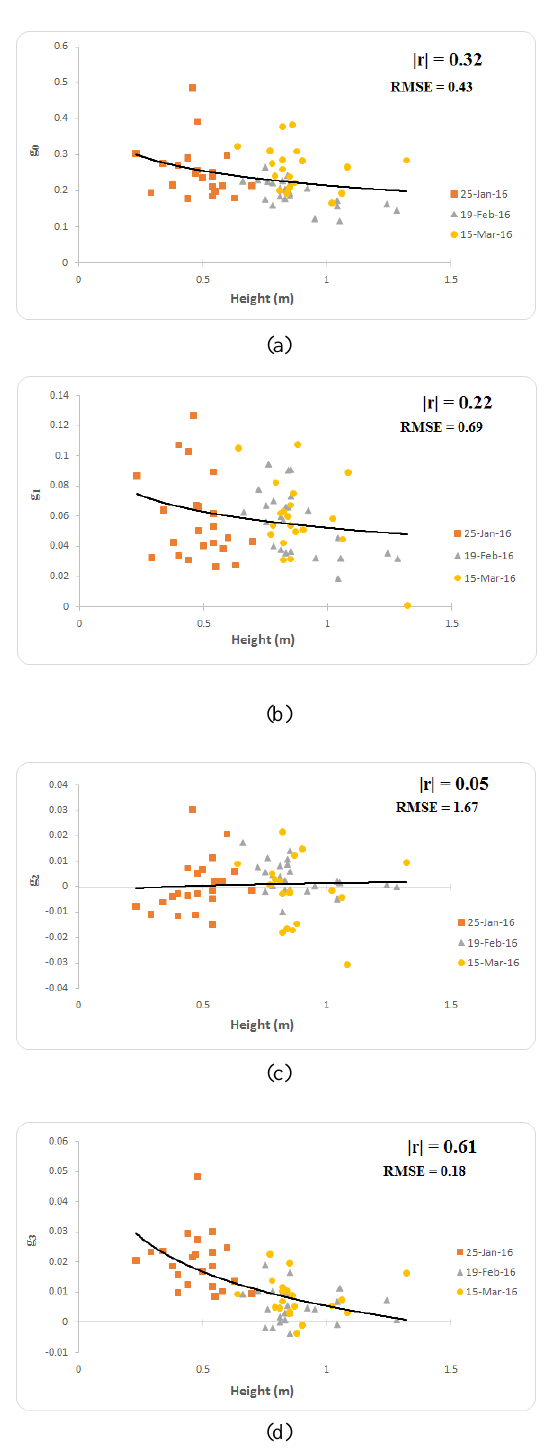
Figure 5. Scatterplot of Stokes parameters [(a): g 0 ; (b) g 1 ; (c) g 2 ; (d) g 3 ] vs wheat height